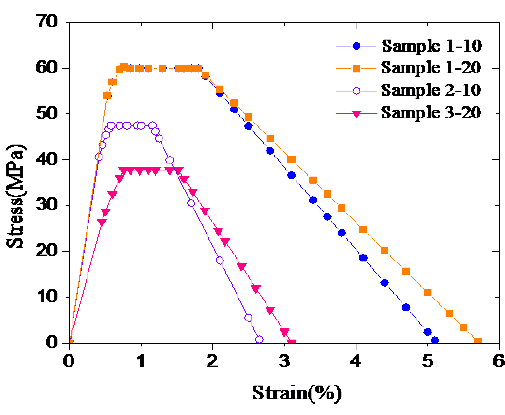
Figure 8. Comparison of numerical calculation with experiment results ( a-d ).